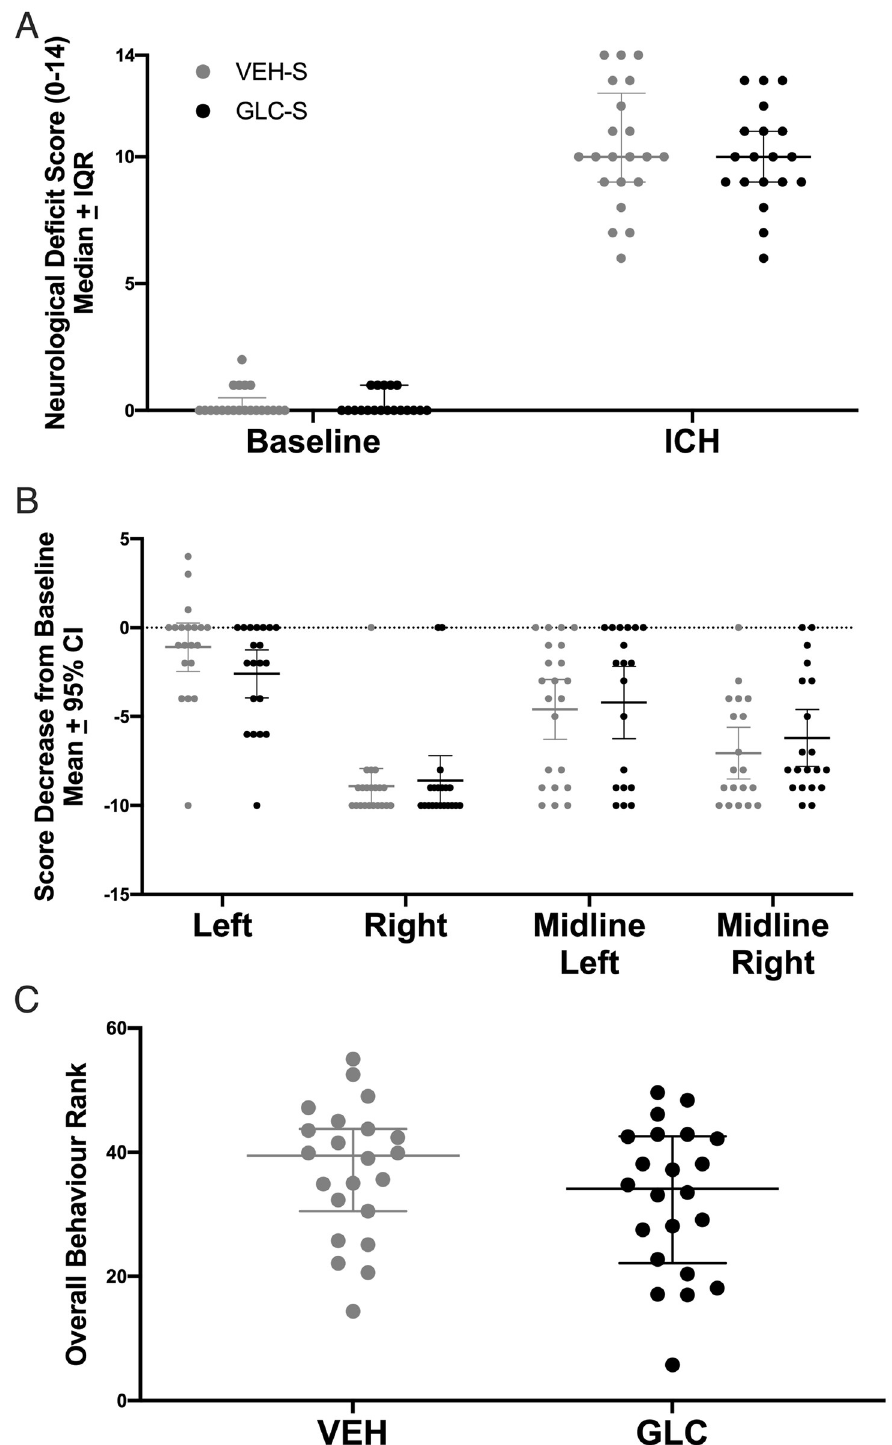
Fig 8. Pooled behaviour. After pooling, severe ICH worsened NDS performance (A, p < 0.0001 vs. baseline), and all paw placements (B, p � 0.0002 vs. baseline) except for the left (ipsilateral) paw (p = 0.0920). For forelimb placing, a dashed line was set at 0, which indicates no change from baseline. After pooling, no meaningful benefit of glibenclamide was found on either NDS (p = 0.7643), forelimb placing of any paw (p � 0.1711), or overall behaviour rank (C, p = 0.2180). NDS and forelimb placing data for the moderate stroke group is in Fig 4.